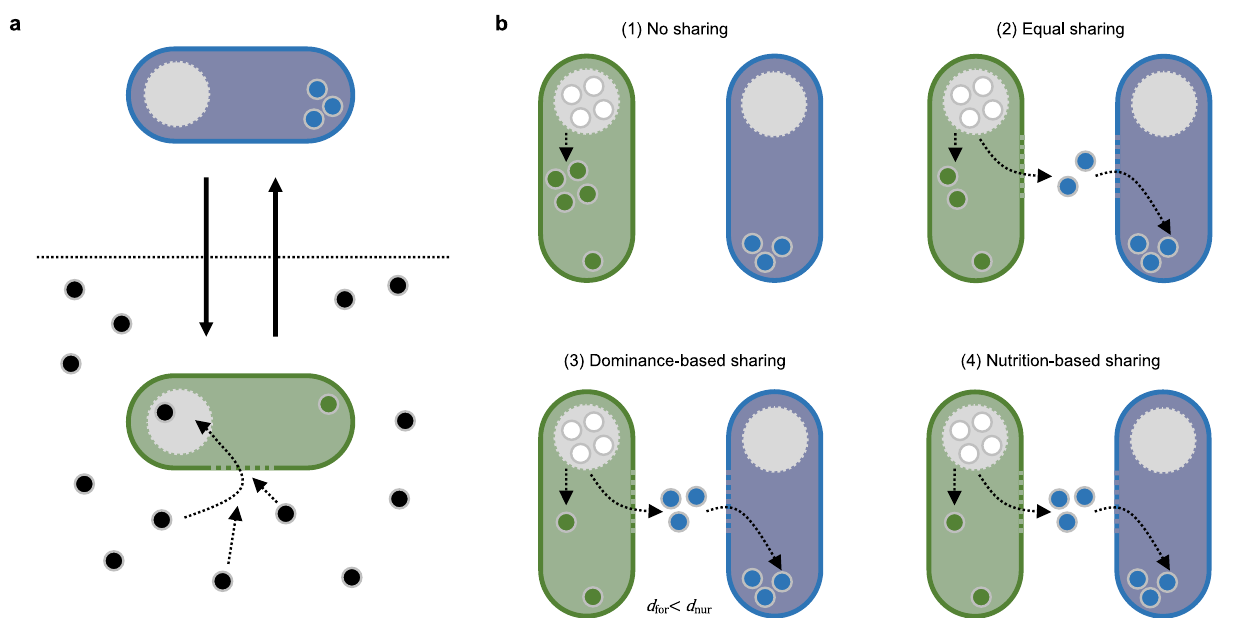
Fig.1|Taskswitchingandfourresourcesharingscenarios.a Ourmodelassumes thatindividualscan switch (solid arrows) betweentwostates: foraging (green) and nursing (blue).While foraging,individuals retrieve resources (black dots) from the environment and store these resources in a temporary storage organ (grey circle). As long as resources are in the storage organ, they can in principle be shared with otherindividuals.Oncetheyareintegratedintotheindividual ’ sbody(greendotsin foraging individuals; blue dots in nursing individuals) they contribute to the indi- vidual ’ s nutrition level and can no longer be shared. As foraging is triggered by a lownutritionlevel,foragingindividualshaveonaveragelowernutritionlevelsthan